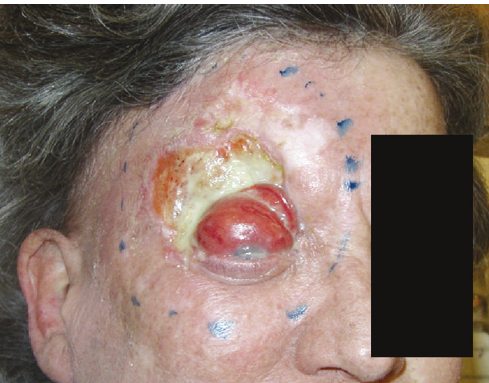
Figure 1: Patient treated with concomitant chemoradiotherapy: 60-year-old white female with an unresectable locally advanced T4 basal carcinoma of the right forehead involving the frontal sinus, lateral orbit, extraocular muscles, and eyelid. She received 70Gy of radiation given concomitantly with weekly cisplatin 30mg/m 2